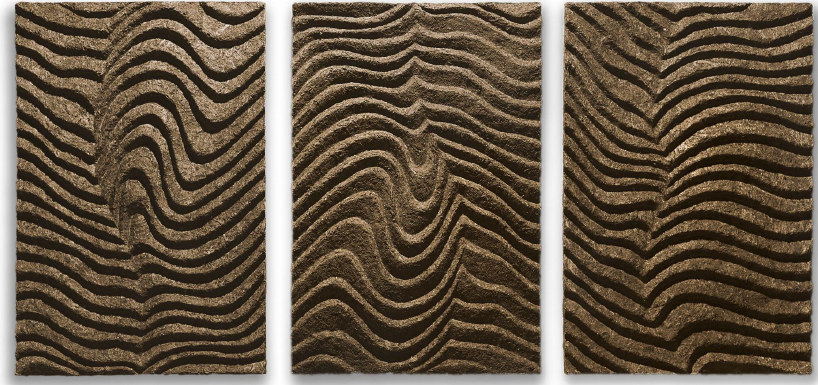
Figure 3. Sound absorption material from fillers (flax fiber and moss) with sapropel as a binder.